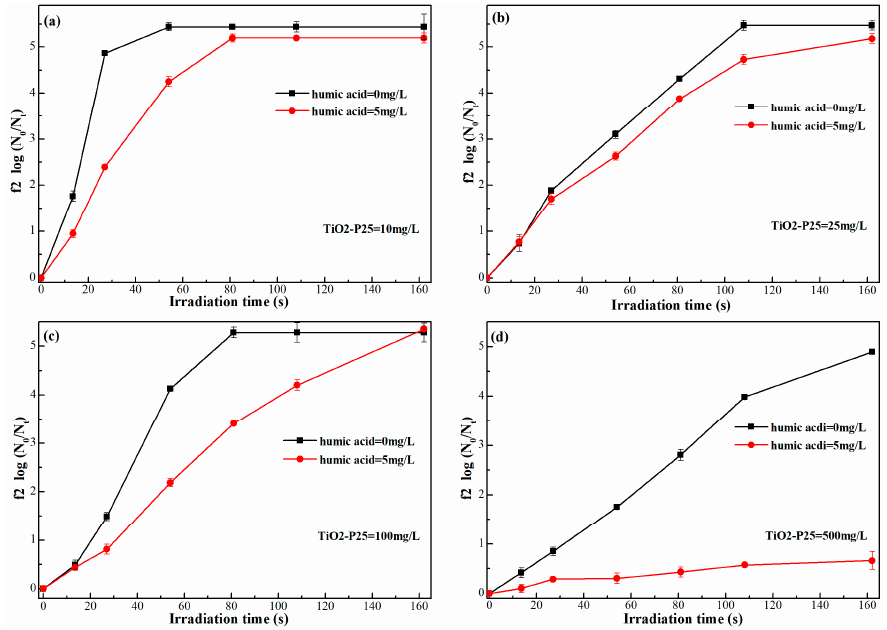
Figure 3. The effect of humic acid on photocatalytic disinfection efficiency of TiO 2 -P25 with different concentrations (a: 10 mg/L; b: 25 mg/L; c: 100 mg/L; d: 500 mg/L).